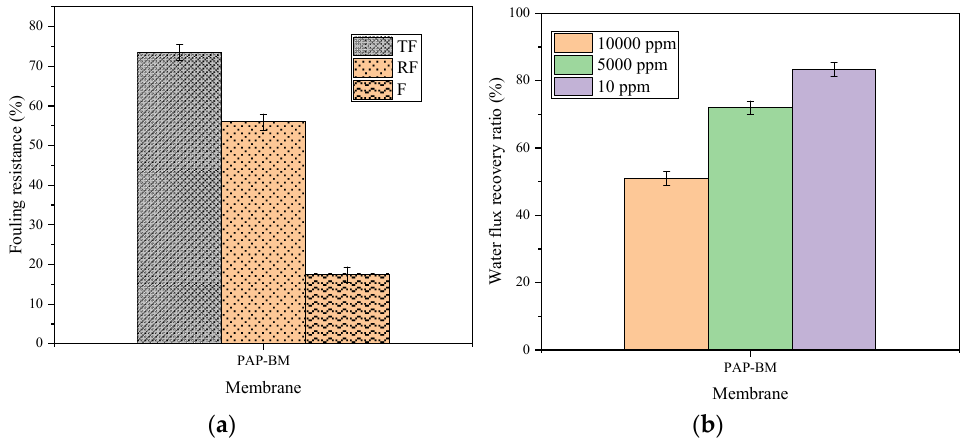
Figure 10. PAP-BM: ( a ) Fouling resistance efficiency and ( b ) water flux recovery percentage.